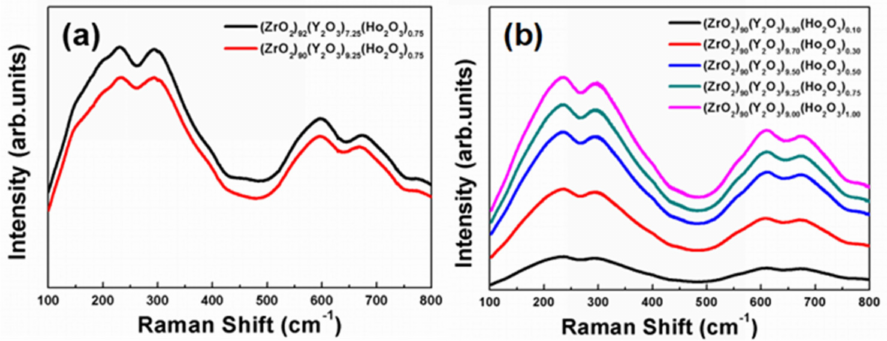
Figure 4. ( a ) Raman spectra of (ZrO 2 ) 92 (Y 2 O 3 ) 7.25 (Ho 2 O 3 ) 0.75 and (ZrO 2 ) 90 (Y 2 O 3 ) 9.25 (Ho 2 O 3 ) 0.75 . ( b ) Raman spectra of (ZrO 2 ) 90 (Y 2 O 3 ) 10 − x (Ho 2 O 3 ) x .